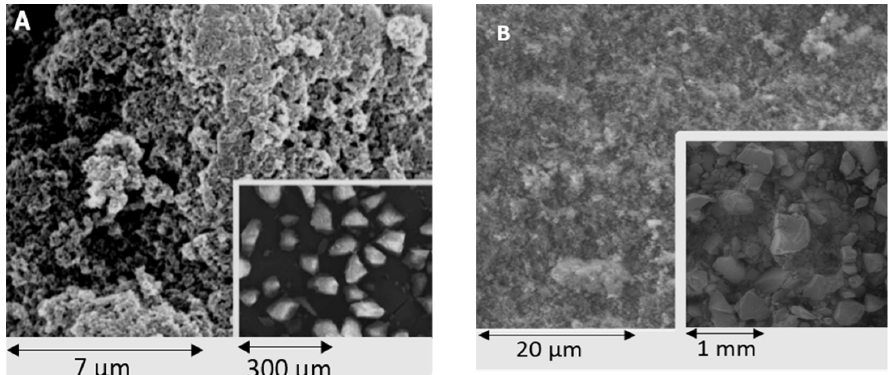
Figure 2. Scanning electron microscopy pictures of Bulk synthesized MIP by Gallegos-Gallegos [28] ( A ) and in this study ( B ).